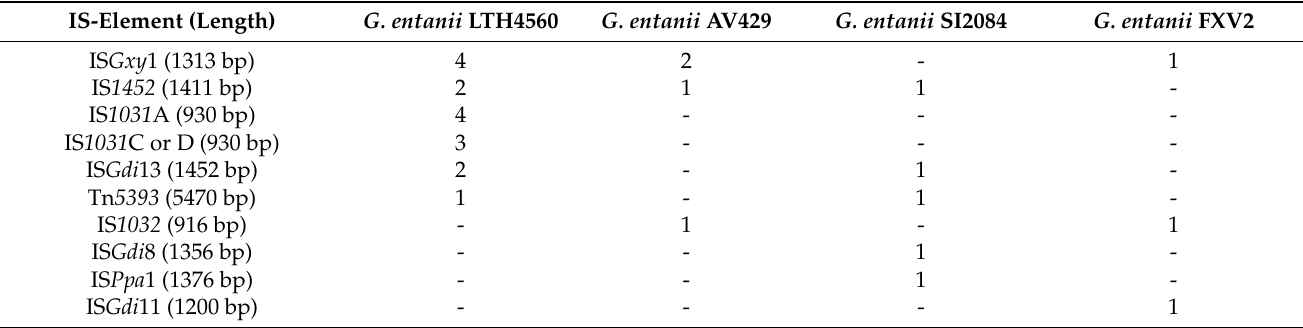
Table 5. Distribution of IS-elements among Gluconacetobacter entanii strains.